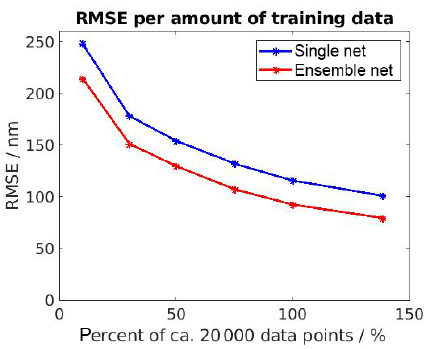
Figure 8. Root mean squared error (RMSE) of a single network (blue) and a network ensemble (red), depending on the amount of data used for training. The test set is the same for all evaluations and was not included in training.